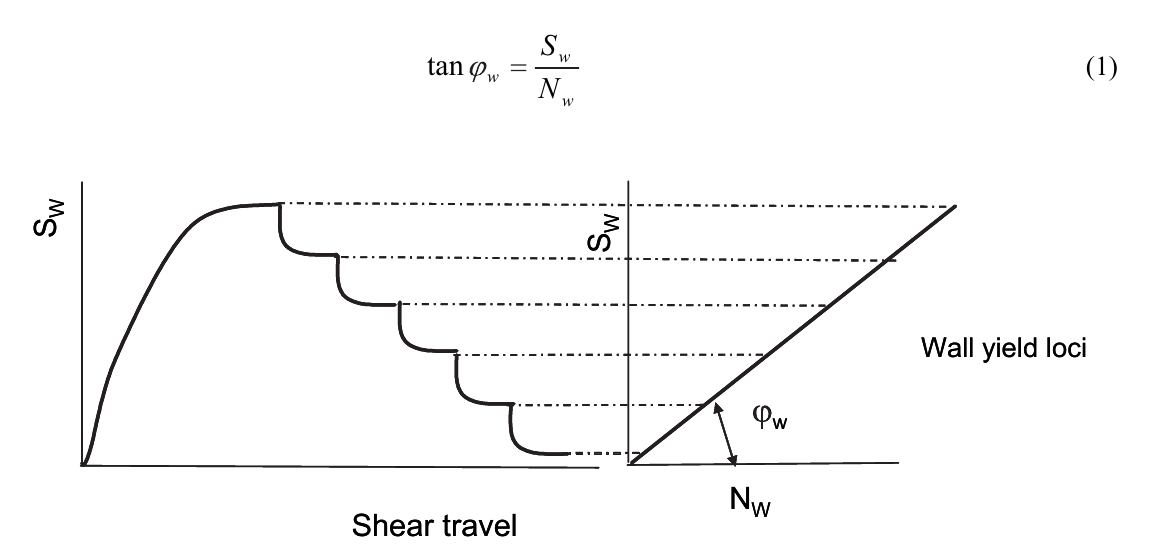
Fig. 2 Wall Yield Locus (WYL) Obtained by the Ring Shear Tester [4].